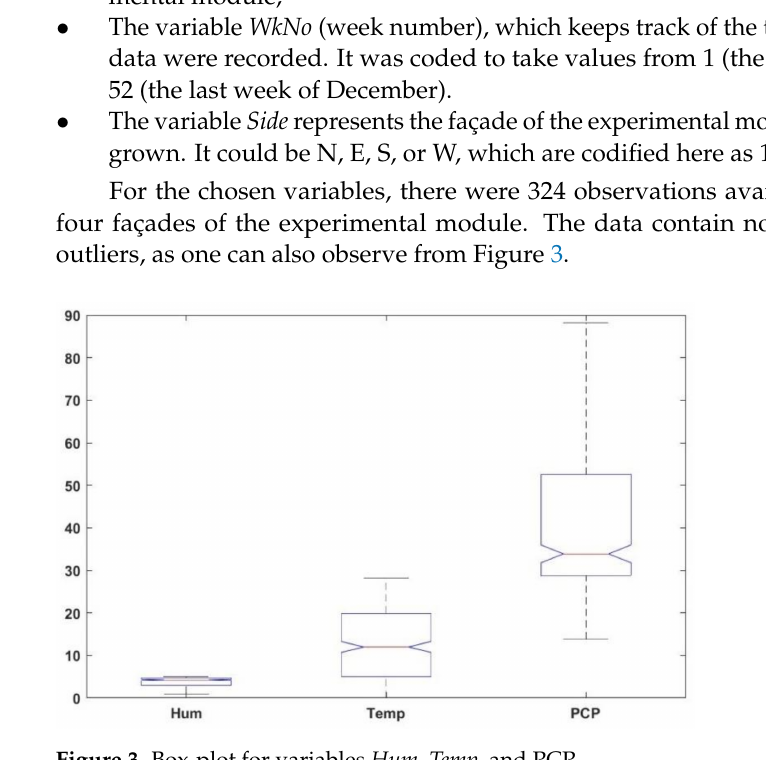
Figure 3. Box-plot for variables Hum , Temp , and